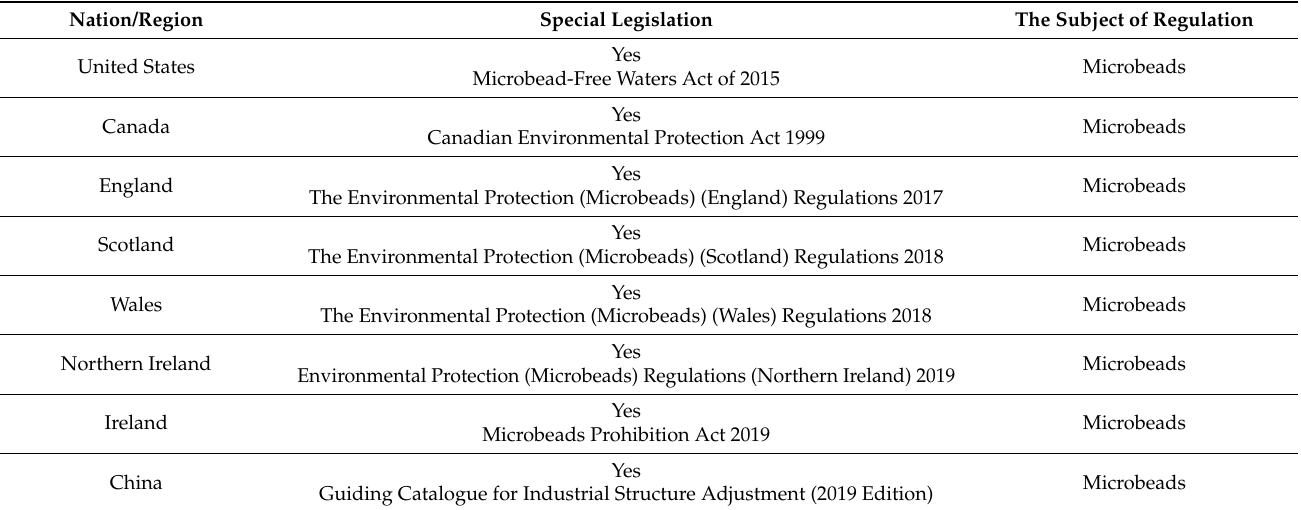
Table 1. National